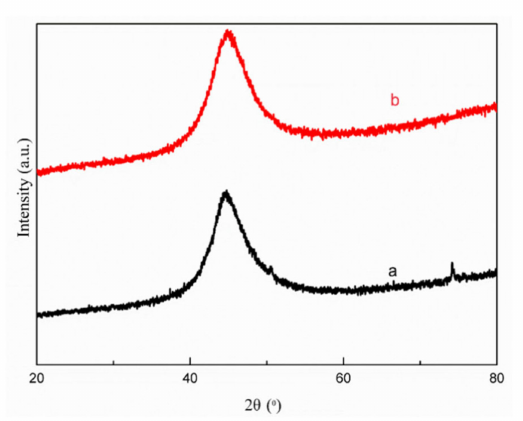
Figure 10. XRD patterns of the ( a ) NiP, and ( b ) NiCrP 4 alloy coatings.